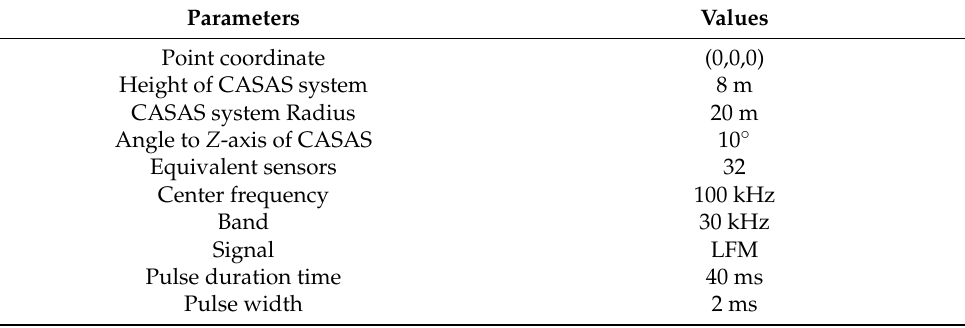
Figure 4. The 3D PSF of circular array synthetic aperture sonar. ( a ) Slice of CASAS 3D PSF in (0,0,0); ( b ) Slice of CASAS 3D PSF in (0,0,7); and ( c ) 3 D PSF of CASAS. Table 1. CASAS system parameters for